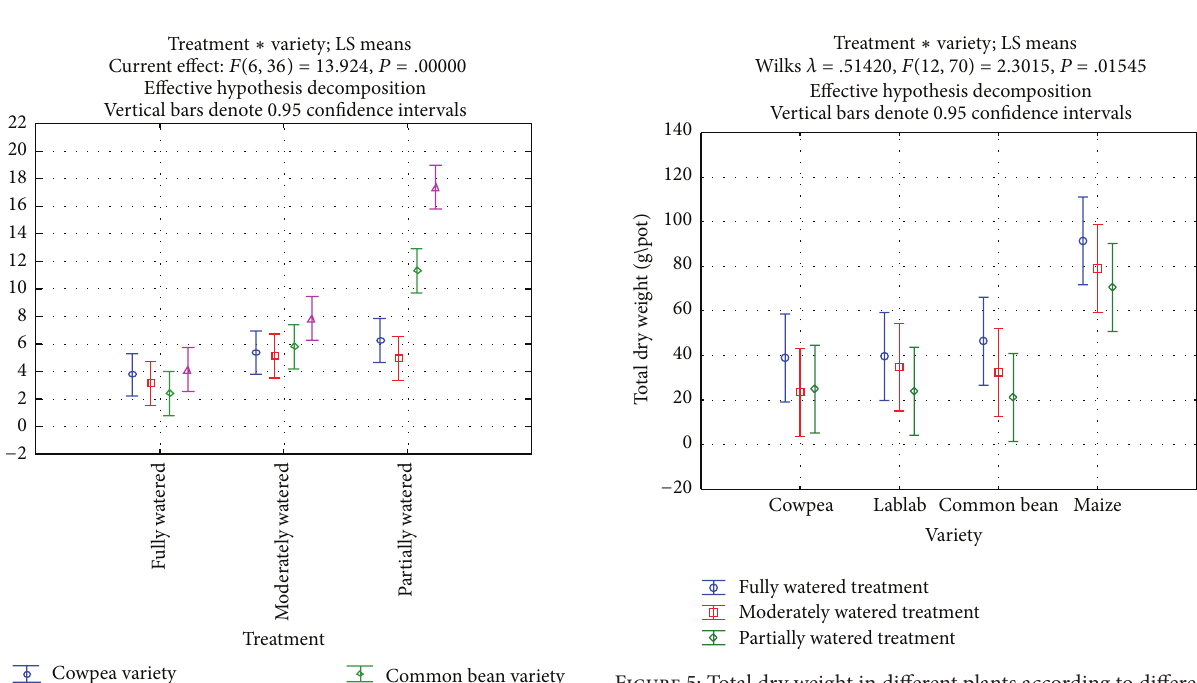
Figure 5: Total dry weight in different plants according to different watering treatments.